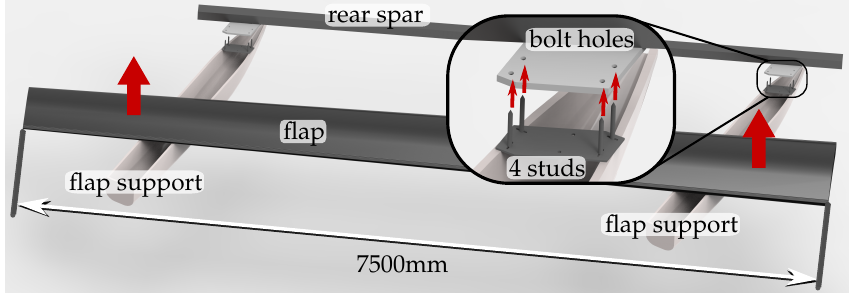
Figure 3. Rendering showing the flap with supports and a mock-up of the airplanes rear spar Flaps of aircrafts represent a particularly challenging component for the assembly of